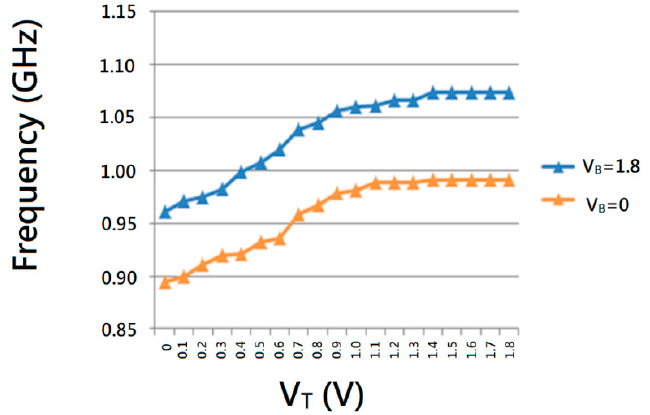
Figure 9. Kvco curve of proposed VCO at different frequency mode.